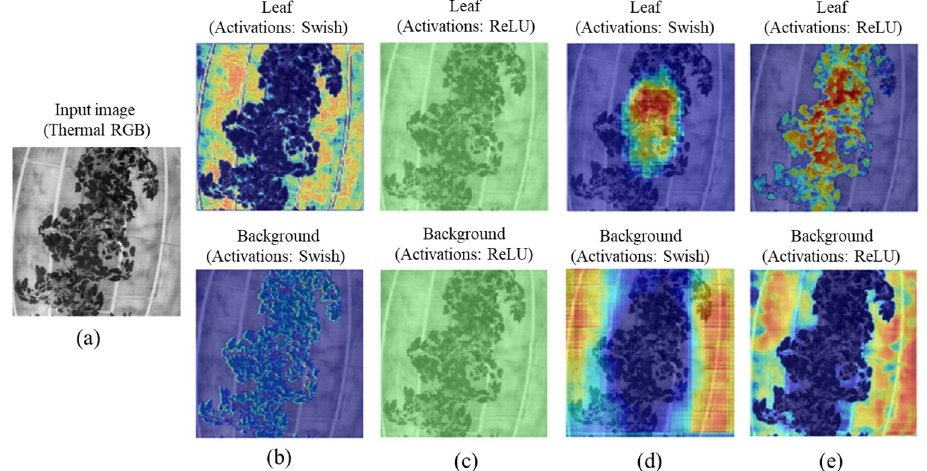
Figure 14. Visualization of the Grad-CAM in different depth of the network: ( a ) monochrome thermal RGB image; ( b ) Grad-CAM visualization at shallow depth of the encoding layer; ( c ) Grad-CAM visualization at middle depth of the encoding layer; ( d ) Grad-CAM visualization at deep depth of the decoding layer; ( e ) Grad-CAM visualization at deep depth of the classification layer.